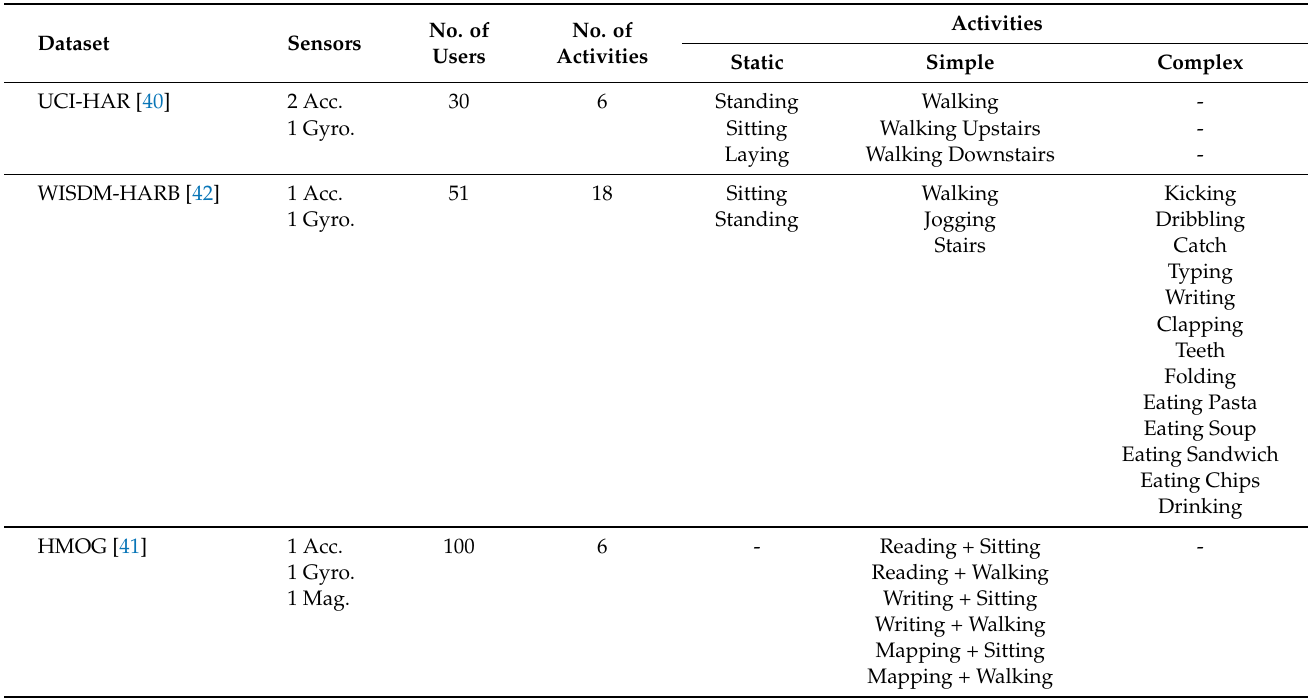
Table 2. Characteristics of the selected datasets used to evaluate deep learning models in this work.